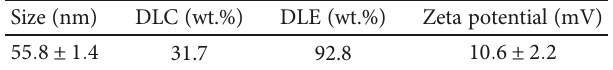
Table 1: Particle size, DLC, DLE, and zeta potential of CS/HCPT.